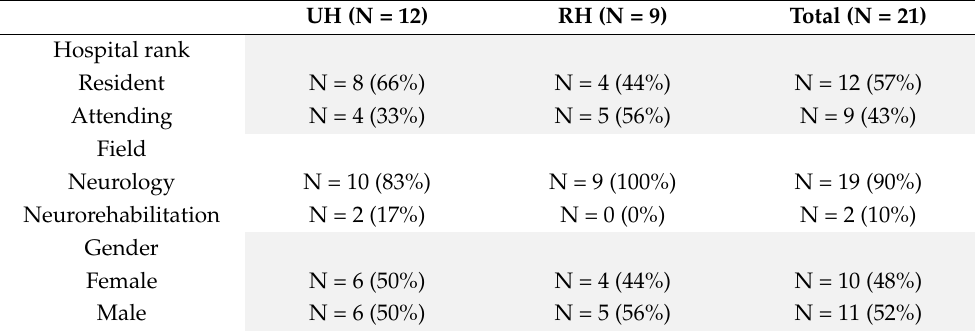
Table 1. Characteristics of study